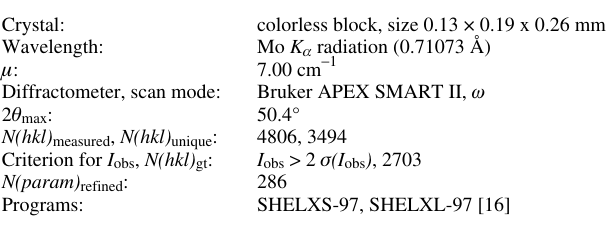
Table 1. Data collection and